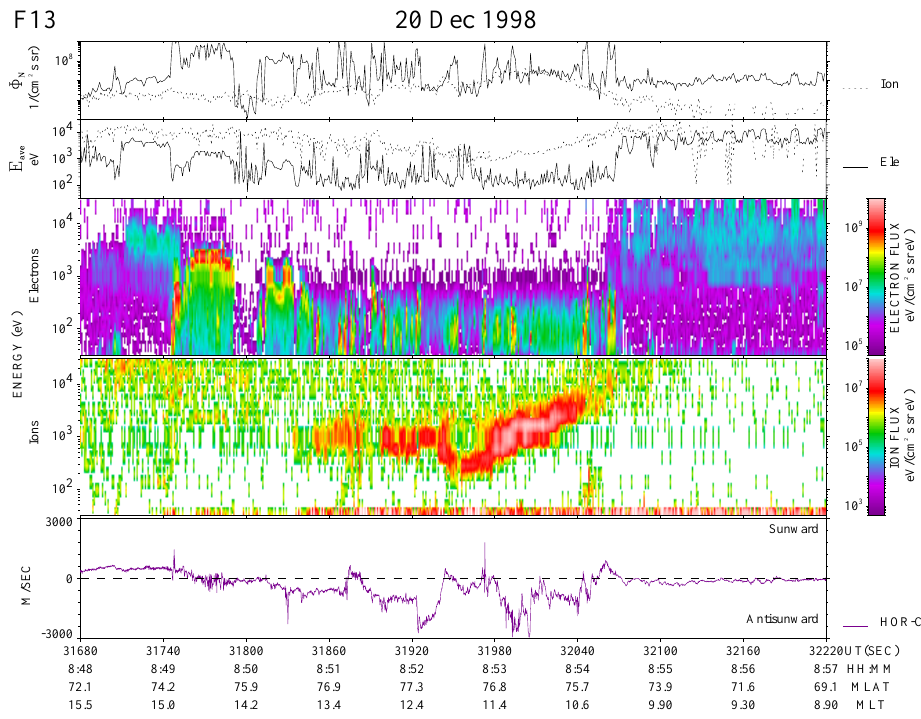
Fig. 6. Particle data and horizontal cross trajectory plasma flow velocities measured by the F13 satellite of the Defence Meteorological Satellite Programme (DMSP) along an essentially east-to-west geomagnetic path, crossing the noon meridian at about 08:52 UT on 20 December 1998.